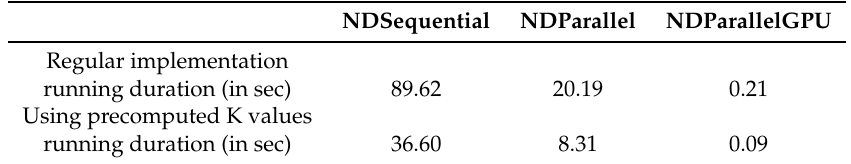
Table 2. Time comparison for the three diffusion algorithm types running on a 256 × 256 image.